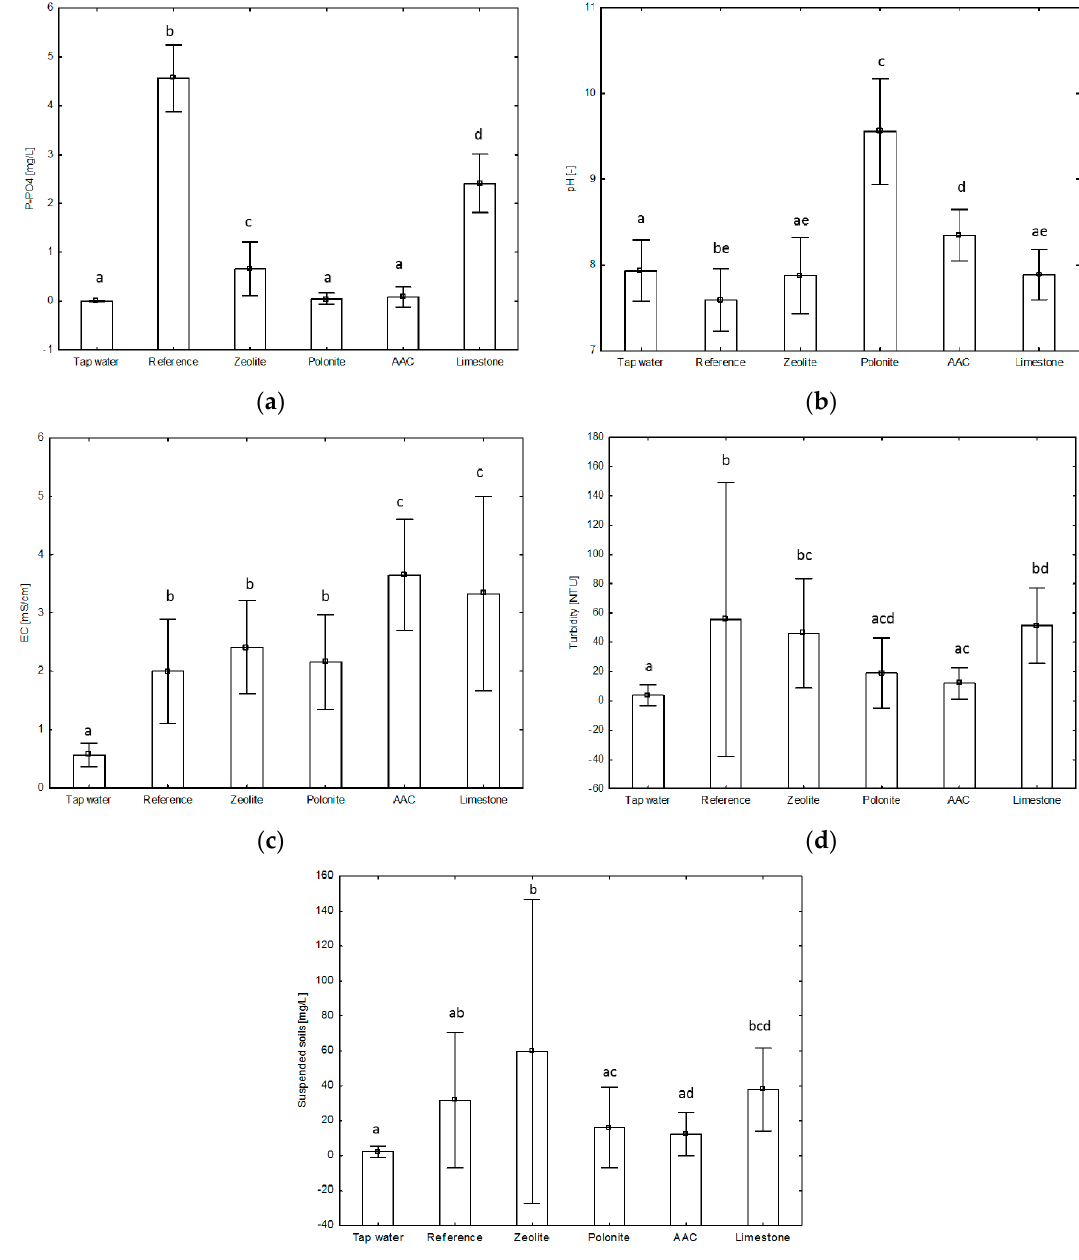
Figure 3. The P-PO 4 ( a ); pH ( b ); electrical conductivity (EC) ( c ); turbidity ( d ) and suspended solids ( e ) changes of simulated precipitation (tap water), leakages from the reference and PRBs columns over the duration of the experiment.